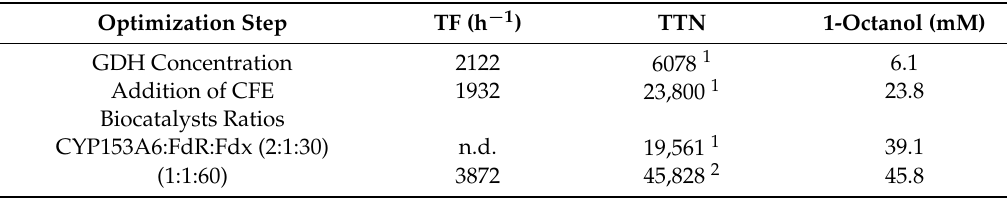
Table 1. Optimization of CYP153A6 biotransformations as evaluated through initial reaction rates (TF) and stability